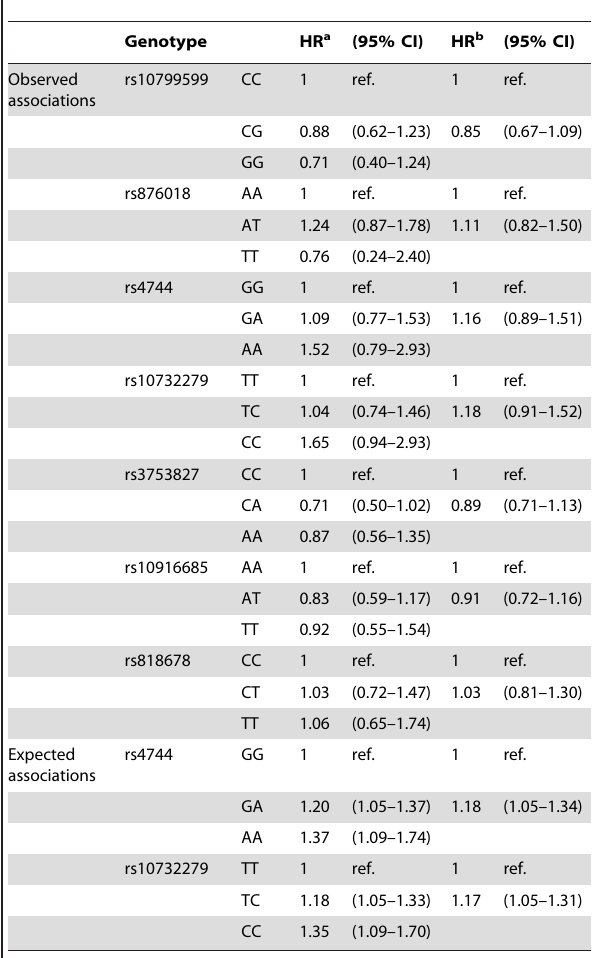
Table 4. Observed and expected relative